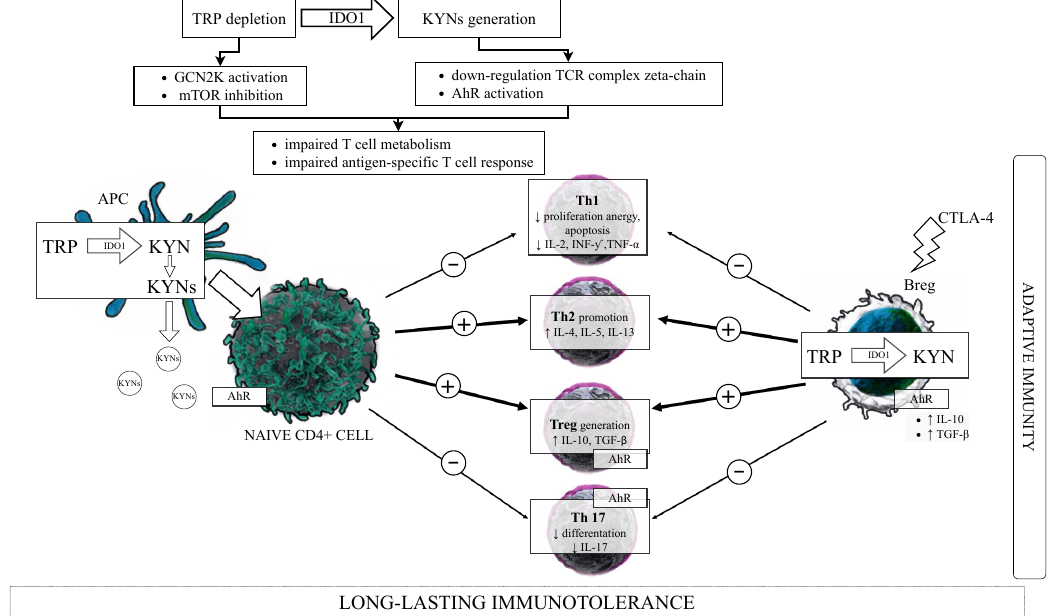
Figure 3. The role of the indoleamine 2,3-dioxygenase-1 (IDO1) and kynurenine pathway metabolites in adaptive immu- nity. The induction of IDO1 expression on professional APC leads to TRP depletion and KYNs generation in the local microenvironment. Together, TRP deprivation and KYNs-dependent activation of AhR signaling result in metabolic stress sensed by GCN2K, mTOR, and TCR complex zeta-chain, leading to impaired T cells metabolism and their antigen-specific response. The activation of IDO1-dependent KP in APC can directly affect the differentiation of na ї ve CD4+ T cells by cell cycle arrest and apoptosis of Th1 cells, inhibition of differentiation of Th17 cells while promoting Th2 cells polarization. KYN metabolites, by signaling via the AhR, can also direct the conversion of na ї ve CD4+ T cells to the immunosuppressive phenotype of Treg and prevent its reprogramming to effector Th17 cell. Similar effects on cells of the adaptive immune system are exerted by IDO1 activation in the Breg, which regulates T cell responses via the release of IL-10 and TGF- β , the suppression of Th1, Th17 cells, and by converting CD4+T cell into Treg. In summary, the IDO1-dependent pathway of TRP degradation may alter Th1/Th2 and Th17/Treg balance and create the local milieu, that is dominated by anti-inflammatory cytokines (IL-10, IL-4, TGF- β ), contributing by this way to the long-lasting immunotolerance. Abbreviations: TRP— tryptophan; IDO1—indoleamine 2,3-dioxygenase 1; KYN—kynurenine; KYNs—kynurenines; GCN2K—general control nondepressible 2 kinase; mTOR—mammalian target of rapamycin; APC—antygen presenting cel; Th1—T helper type 1 cell; IL—interleukin; IFN- γ —interferon γ ; TNF- α —tumor necrosis factor α ; Th2—T helper type 2 cell; Treg—T regulatory cell; TGF- β —transforming growth factor β ; AhR—aryl hydrocarbon receptor; Th17—T helper type 17; CTLA-4—cytotoxic T-lymphocyte antigen 4; Breg—B regulatory